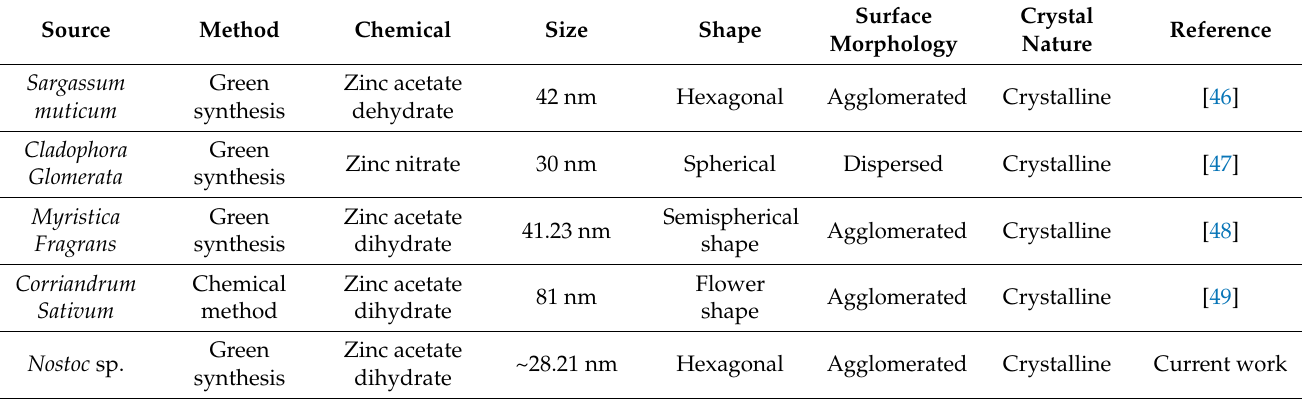
Table 1. Comparative study of physical characterization of ZnONPs.